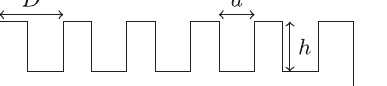
FIG. 13. SPR power P to bunch charge Q distances between beam and grating z 0 . The transverse size of the beam σ z ≈ 100 μ m is not